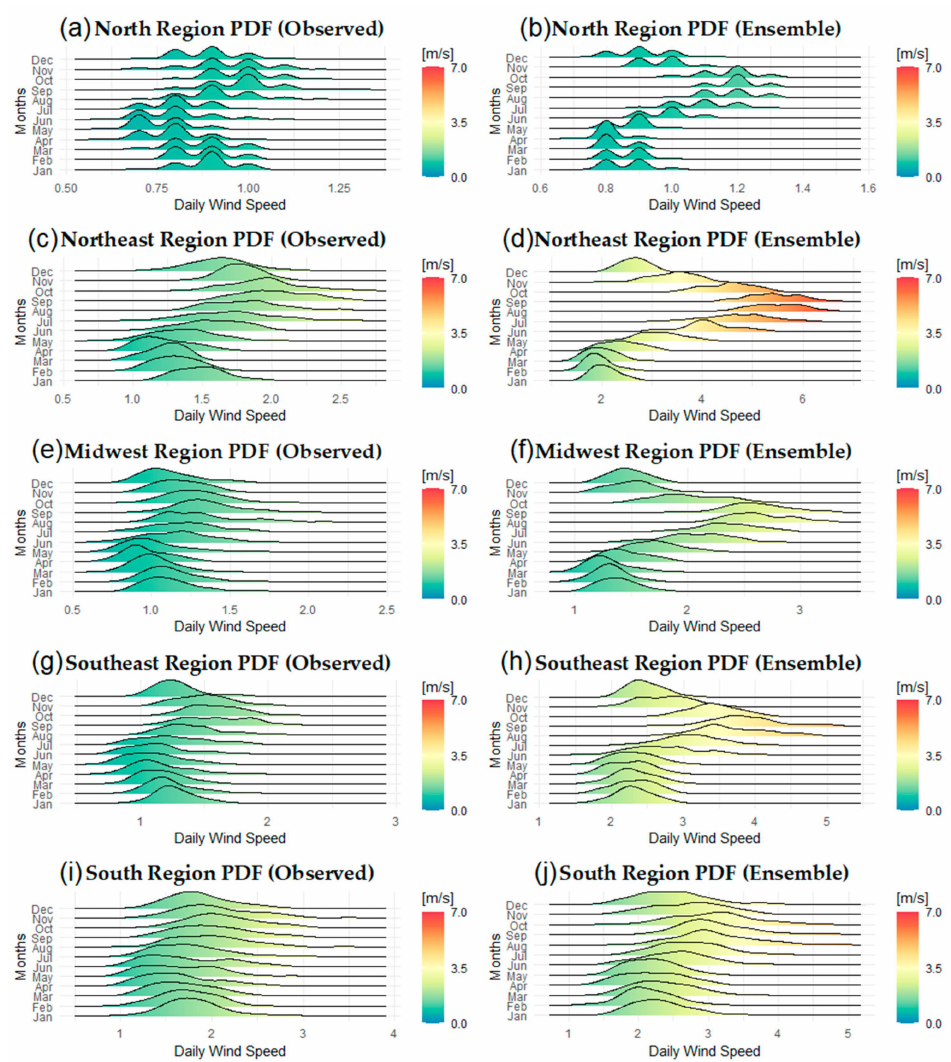
Figure 14. Probability density of wind speed (m/s), with observed data on the left and BAM data on the right, for each Brazilian region: NW ( a , b ), NE ( c , d ), CO ( e , f ), SE ( g , h ), and S ( i , j